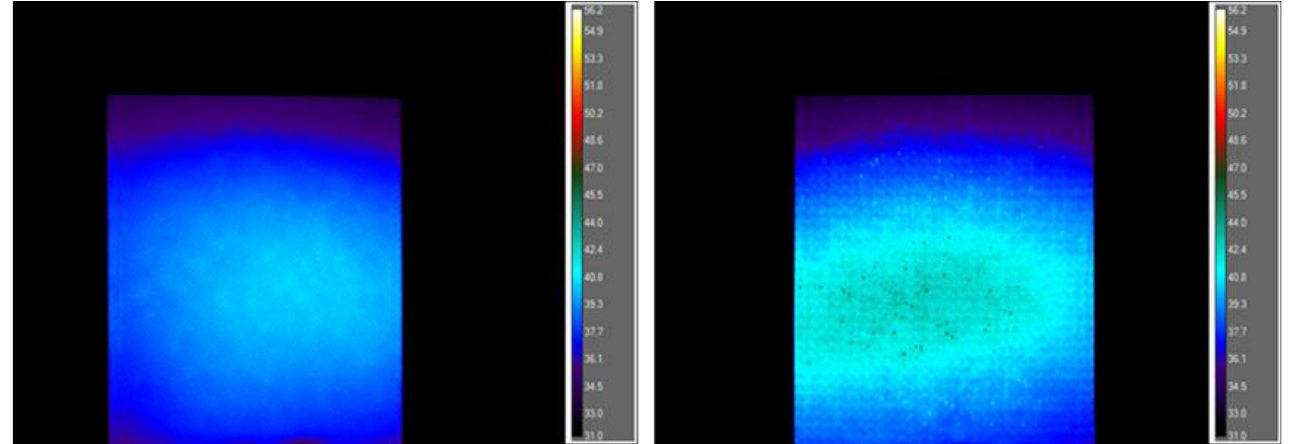
Figure 12. IR thermography of RTM6 ( left ) and 3R ( right ) laminates.